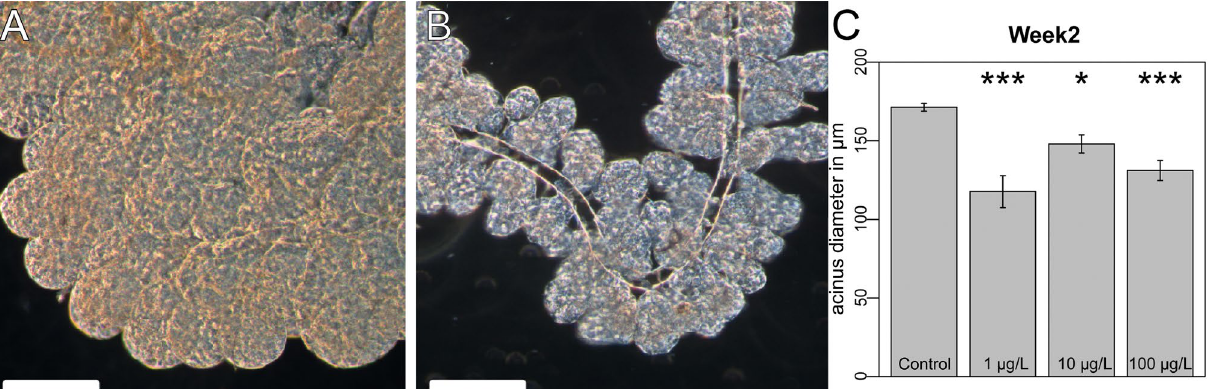
Figure 1. Hypopharyngeal gland size in age-defined worker bees. Age-defined worker bees, which were placed in the colonies and recovered in week 2 (12 days after hatching), were analyzed for the acini size of the HPG. ( A ) HPG of a control worker bee. ( B ) HPG of a worker bee from a colony exposed to 100 µg/L clothianidin (bar = 100 µm). ( C ) Clothianidin exposure reduced the acinus diameter of HPGs. Control individuals had larger acini than workers exposed to clothianidin (control, n = 31; 1 µg/L, n = 22; 10 µg/L, n = 22; 100 µg/L, n = 23). Mixed-effects ANOVA, ( P = 0.0120; post hoc Dunnett contrasts, control vs. 1 µg/L, P < 0.001; control vs. 10 µg/L, P = 0.0345; control vesus 100 µg/L, P = 0.0027). Raw data and technical details of the analysis are presented in the supplementary statistical report, “Hypopharyngeal gland size”